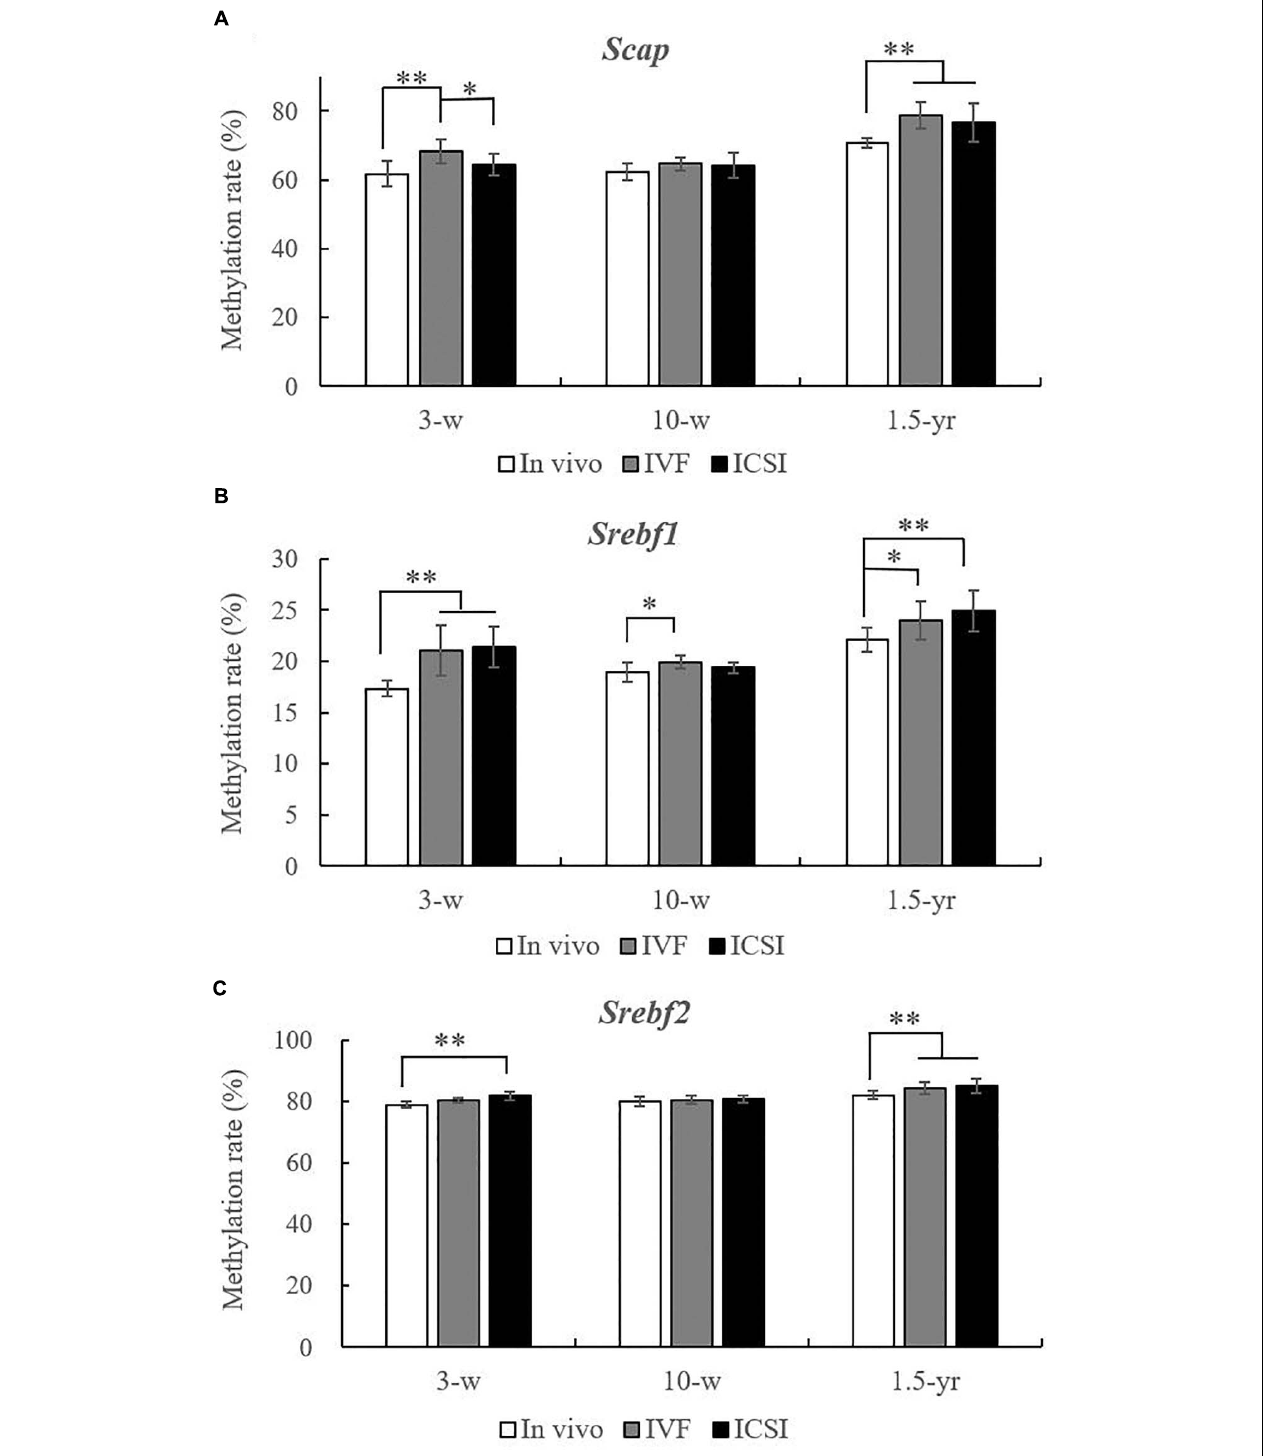
FIGURE 3 | Statistical methylation analysis of S cap , Srebf1 , and Srebf2 in the IVF, ICSI, and in vivo groups ( n = 10/group). (A) DNA methylation rate of S cap at 3 weeks, 10 weeks, and 1.5 years of age. (B) DNA methylation rate of Srebf1 at 3 weeks, 10 weeks, and 1.5 years of age. (C) DNA methylation rate of Srebf2 at 3 weeks, 10 weeks, and 1.5 years of age. Mean ± SD values are plotted. Between-group comparisons were made by one-way analysis of variance (ANOVA).* P < 0.05, ** P < 0.01. 3-w, 3 weeks; 10-w, 10 weeks; 1.5-yr, 1.5 years old.